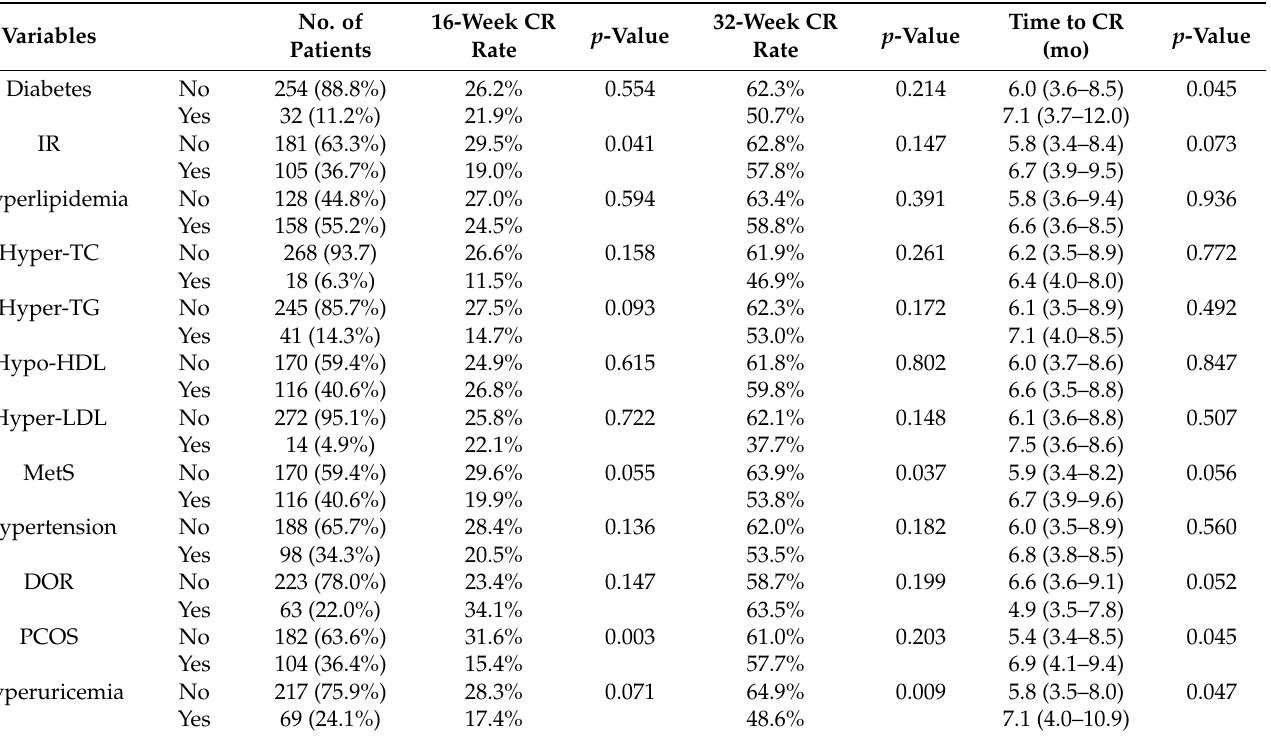
Table 4. Metabolic factors associated with fertility-sparing treatment